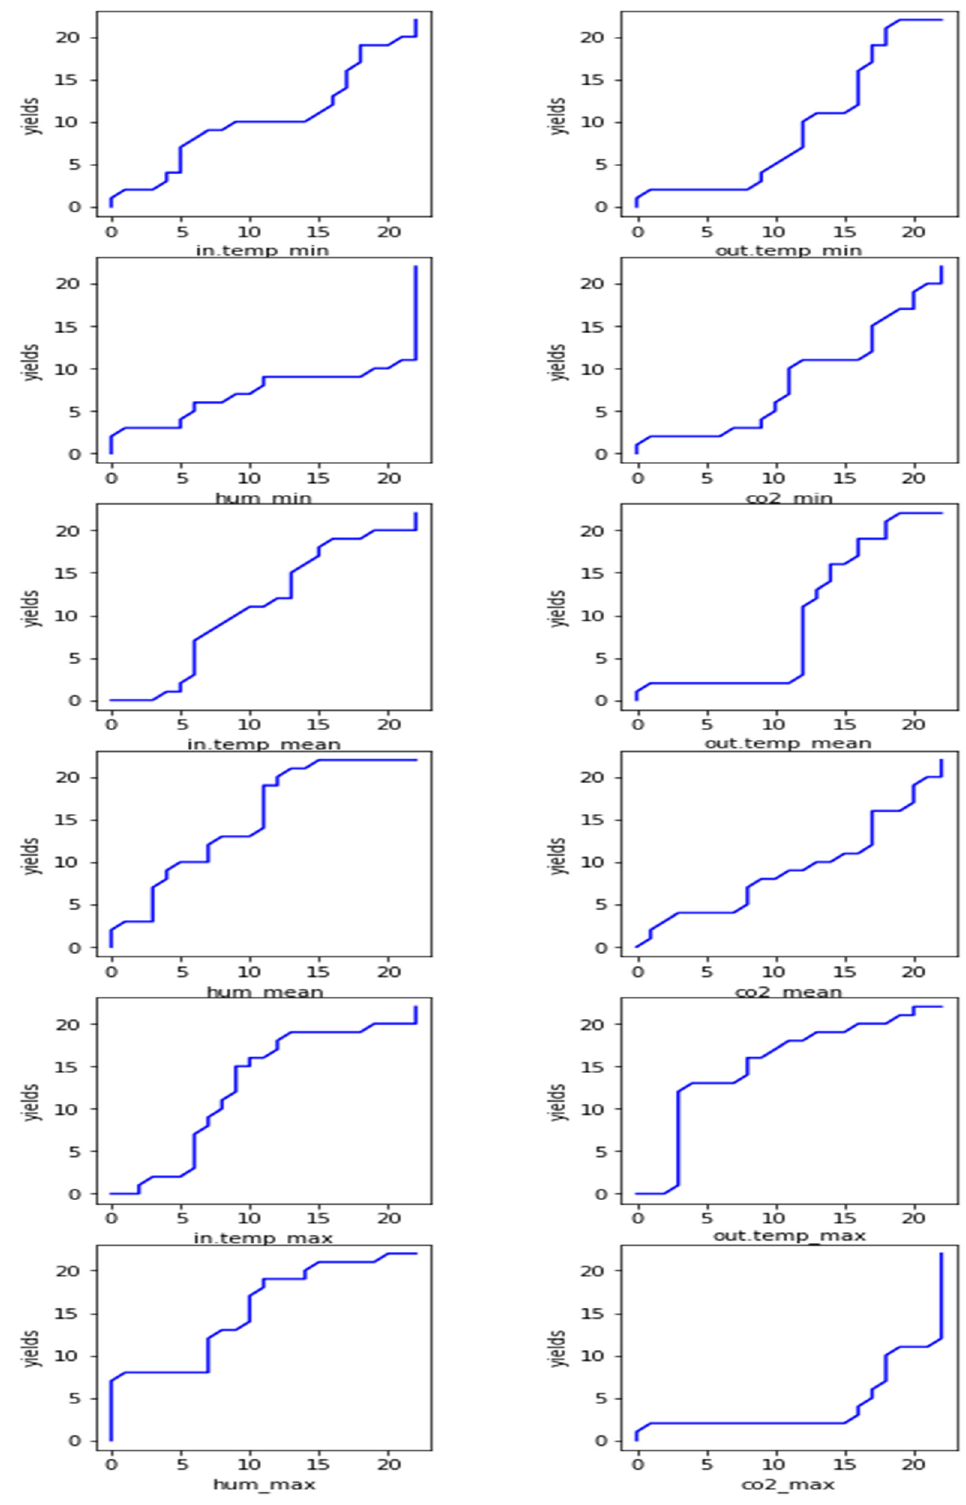
Figure 3. Correlation between environment variables and tomato yields by DTW.